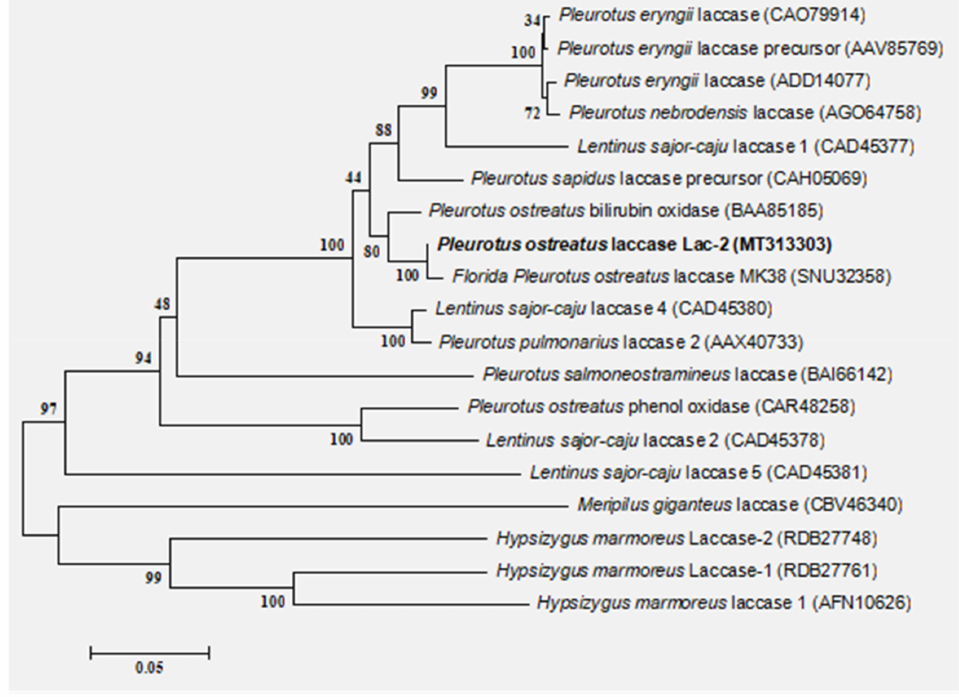
Figure 1. Phylogenetic tree of LAC-2 amino acid sequence. The neighbor-joining tree was constructed in Mega (Version 5.22) by using the Tamura–Nei substitution model and a thousand bootstrap